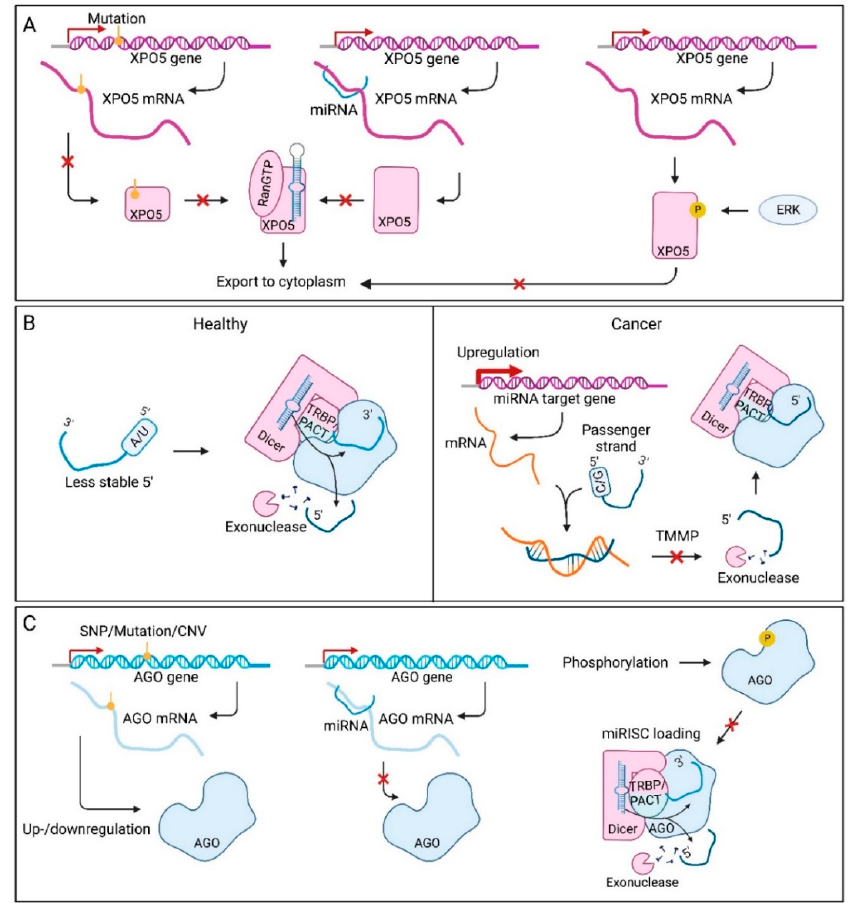
Figure 4. Defective microRNA (miRNA) export, miRNA-induced silencing complex (miRISC) loading and Argonaute (AGO) malfunction, leading to altered miRNA functionality in cancer. ( A ) Exportin-5 (XPO5) exports precursor miRNAs (pre-miRNAs) from the nucleus to the cytoplasm. When the XPO5 gene is mutated, pre-miRNA is retained in the nucleus, resulting in lowered mature miRNA levels. XPO5 functionality can also be altered through post-translational regulation by specific miRNAs. Moreover, phosphorylation by extracellular signal-regulated kinase (ERK) inhibits the shuttling of XPO5 to the cytosol, leading to decreased levels of pre-miRNA in the cytoplasm. ( B ) Loading of one of the miRNA strands into the miRNA ‐ induced silencing complex (miRISC) determines targetome that will be regulated. Strand selection is determined by least 5 ′ end thermodynamics and preferably adenine or uracil nucleotides. The strand that meets these requirements the most, is implemented, whilst the other is degraded. However, when the interaction of the discarded strand with its own target mRNA is strong, this interaction prevents miRNA degradation, leading to arm switching. This mechanism is called target ‐ mediated miRNA protection (TMMP). ( C ) The assembly of the miRISC can also be regulated through differences in AGO proteins. Transcription of the AGO genes can be altered through single nucleotide polymorphisms, mutations or copy number variations (CNVs) in cancer, leading to de ‐ or increased miRNA functionality. AGO can also be targeted by specific miRNAs, creating a negative feedback loop. Moreover, the AGO proteins can be phosphorylated, leading to impaired miRISC loading (Created with BioRender.com).